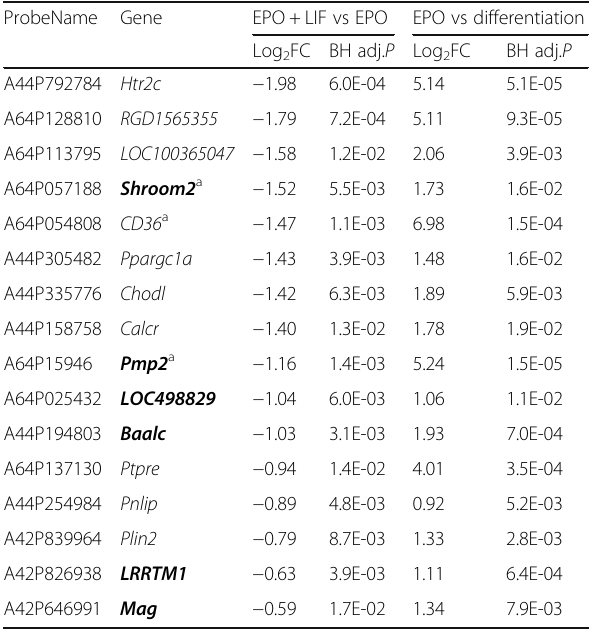
All the genes increased by EPO and inhibited by LIF at 20 h are listed. In bold the genes also increased by differentiation. The full list of the genes increased by EPO and differentiation at 20 h was previously reported (Gyetvai et al., 2017). a Genes represented by 2 probes consistently changed by EPO in the same direction, of which only the most significantly changed one is shown